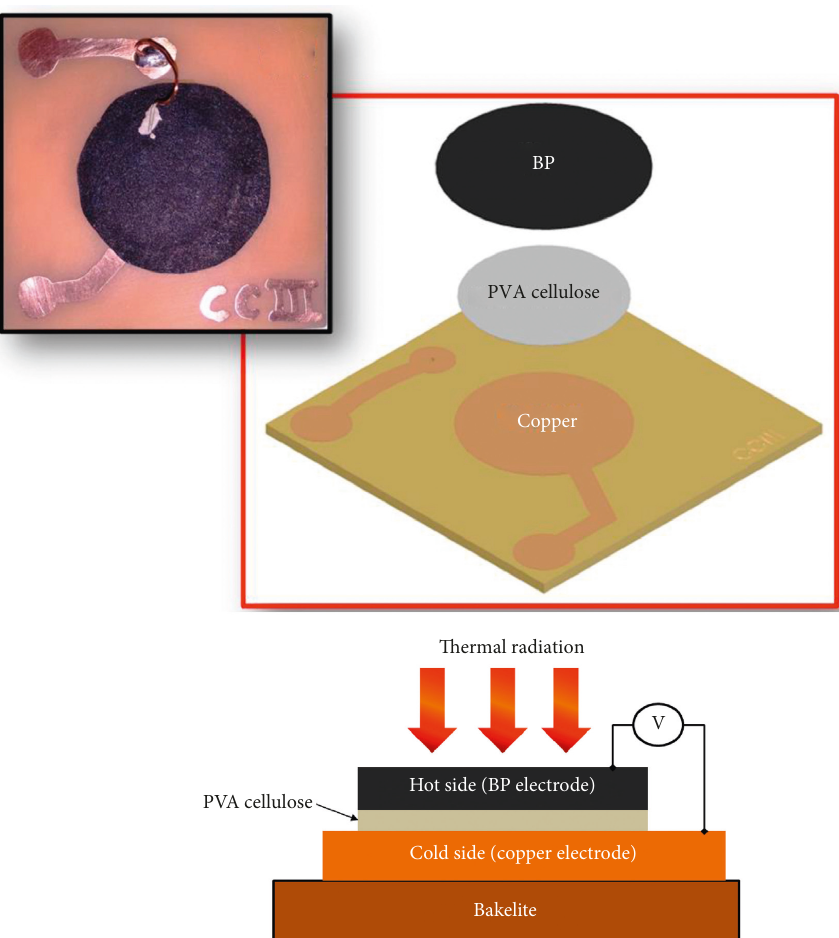
Figure 1: Thermocell designed as a sandwich capacitor, where the BP electrode can be seen in top view (a), the scheme shows the parts of device in perspective (b) and set up used in thermoelectric characterizations (c).